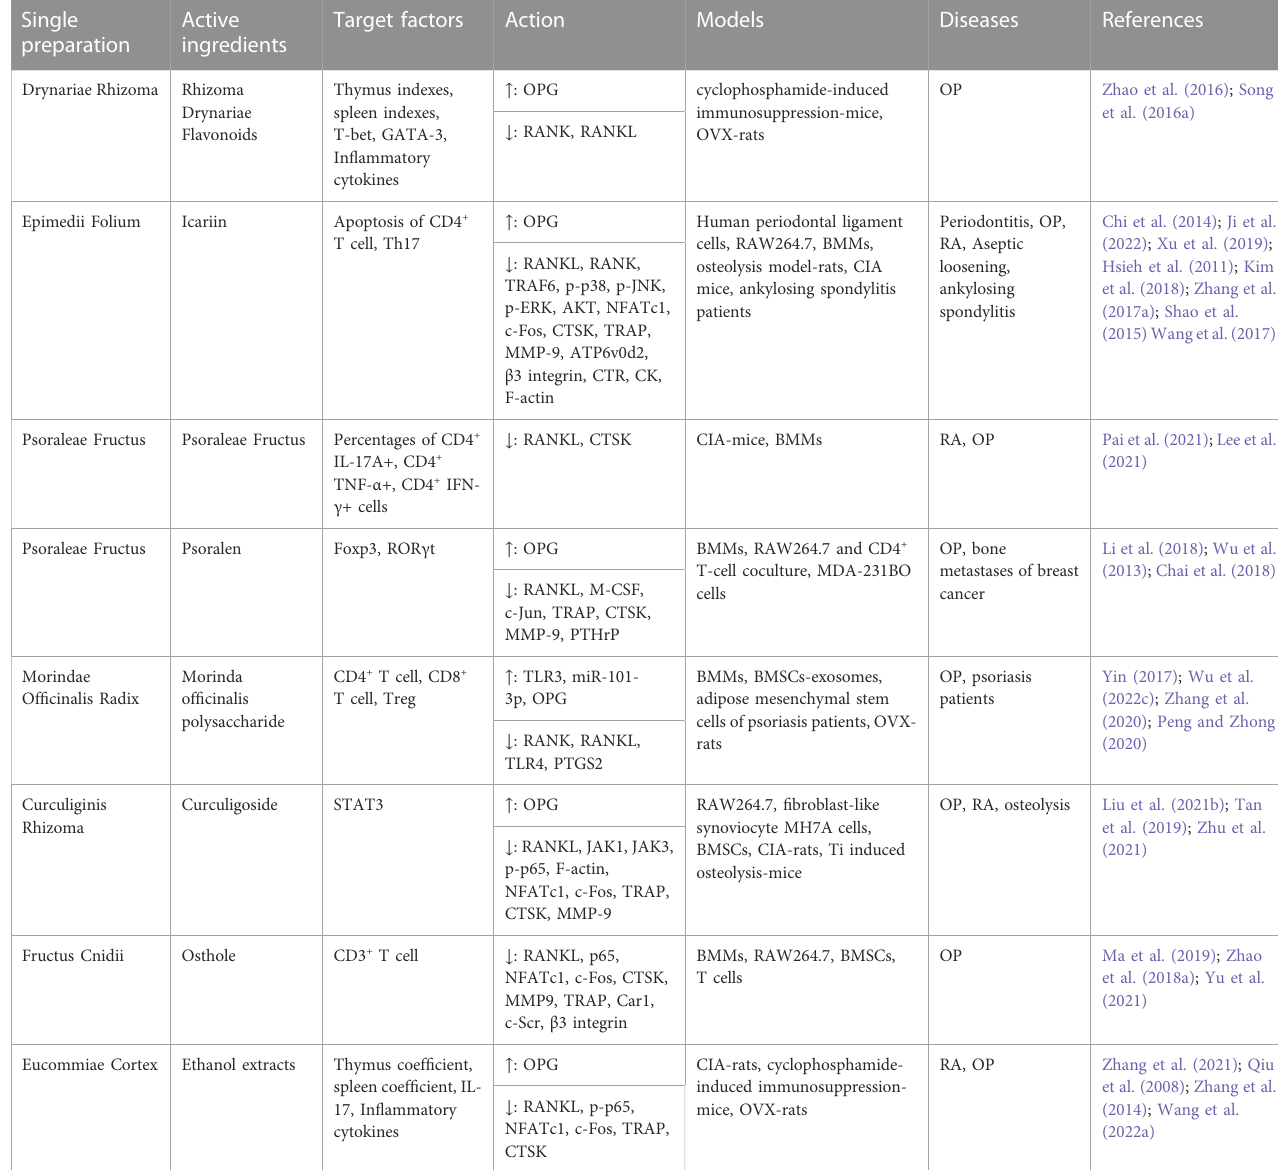
TABLE 2 Immunoregulation mechanisms by which tonifying kidney-yang of single preparations and their active ingredients inhibit